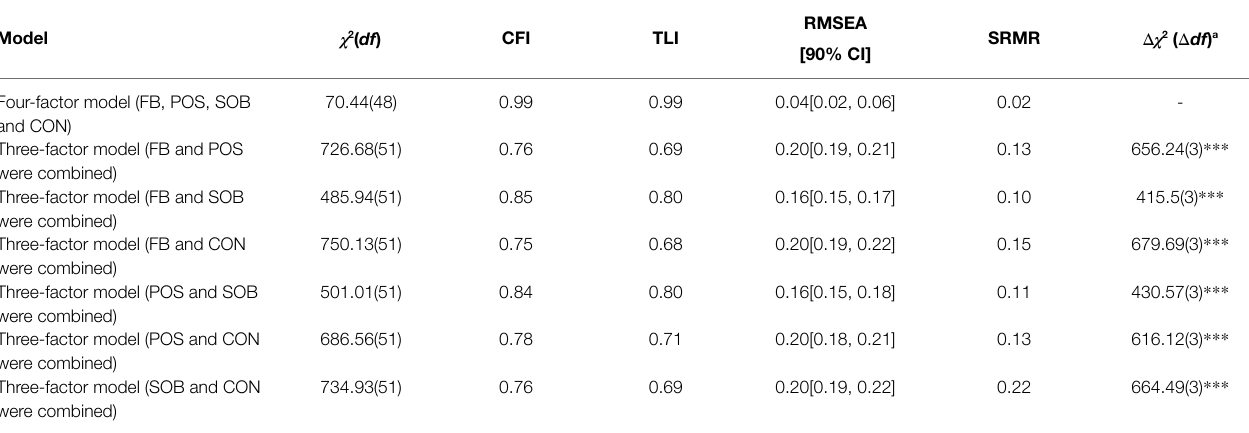
TABLE 2 | Confirmatory factor analysis for discriminant